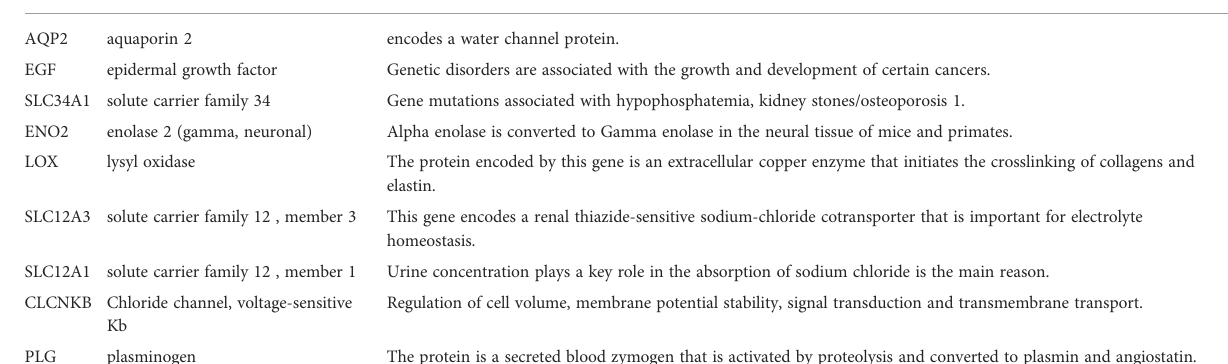
TABLE 1 Functional roles of 9 hub